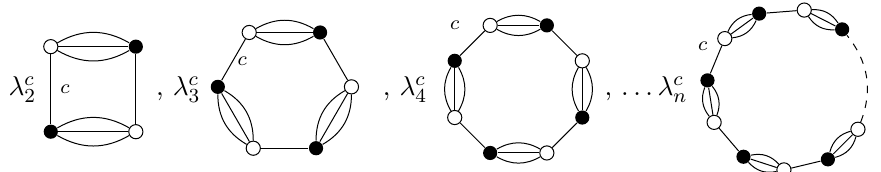
Figure 1 . Cyclic-melonic interaction vertices diagrammatically described by coloured